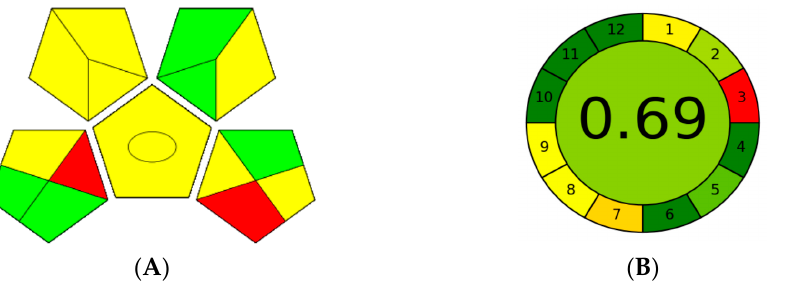
Figure 6. Greenness assessment of the DES–RP-DLLME-HPLC method for tryptophan in oils. ( A ) Figure 5. Greenness assessment of the DES–RP-DLLME-HPLC method for tryptophan in oils. GAPI pentagram; ( B ) AGREE pictogram. ( A ) GAPI pentagram; ( B ) AGREE pictogram.